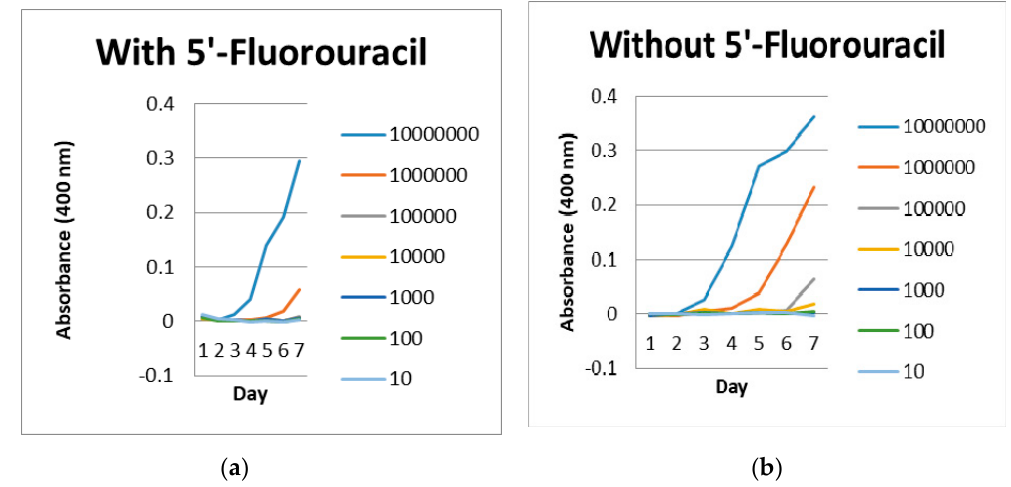
Figure 3. Graph of Leptospira growth with (a) addition of 5’ ‐ fluorouracil and (b) without addition of 5’ ‐ fluorouracil measured by microplate reader.